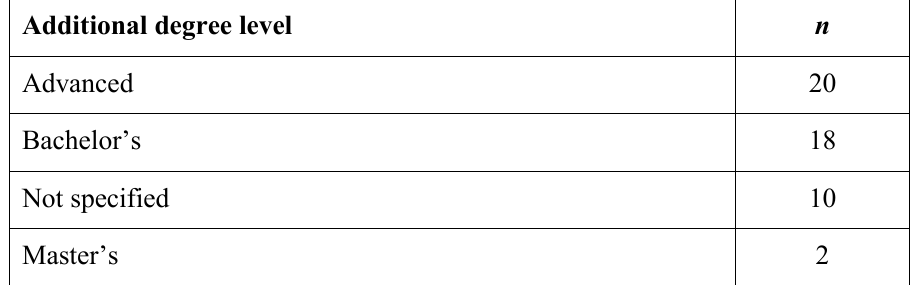
Table 5 : Additional degree levels. Synonyms for advanced were graduate and professional. Multiple levels could be listed.